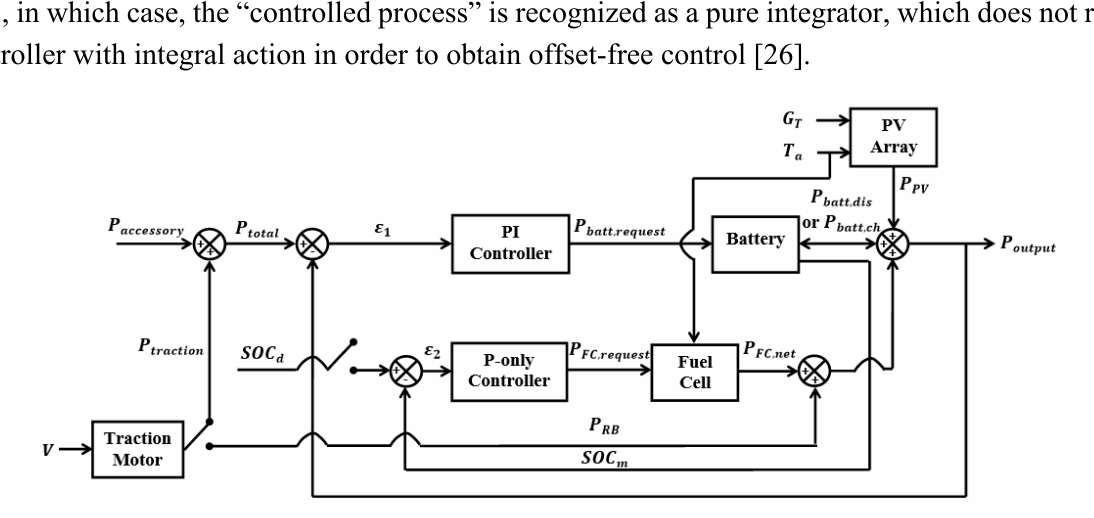
Figure 4. Control block diagram of the PV/fuel cell/ battery HRES under PI